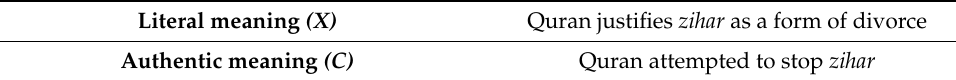
Table 1. The literal and the historicist readings of the zihar verses. Literal meaning (X) Quran justifies zihar as a form of divorce Authentic meaning (C) Quran attempted to stop